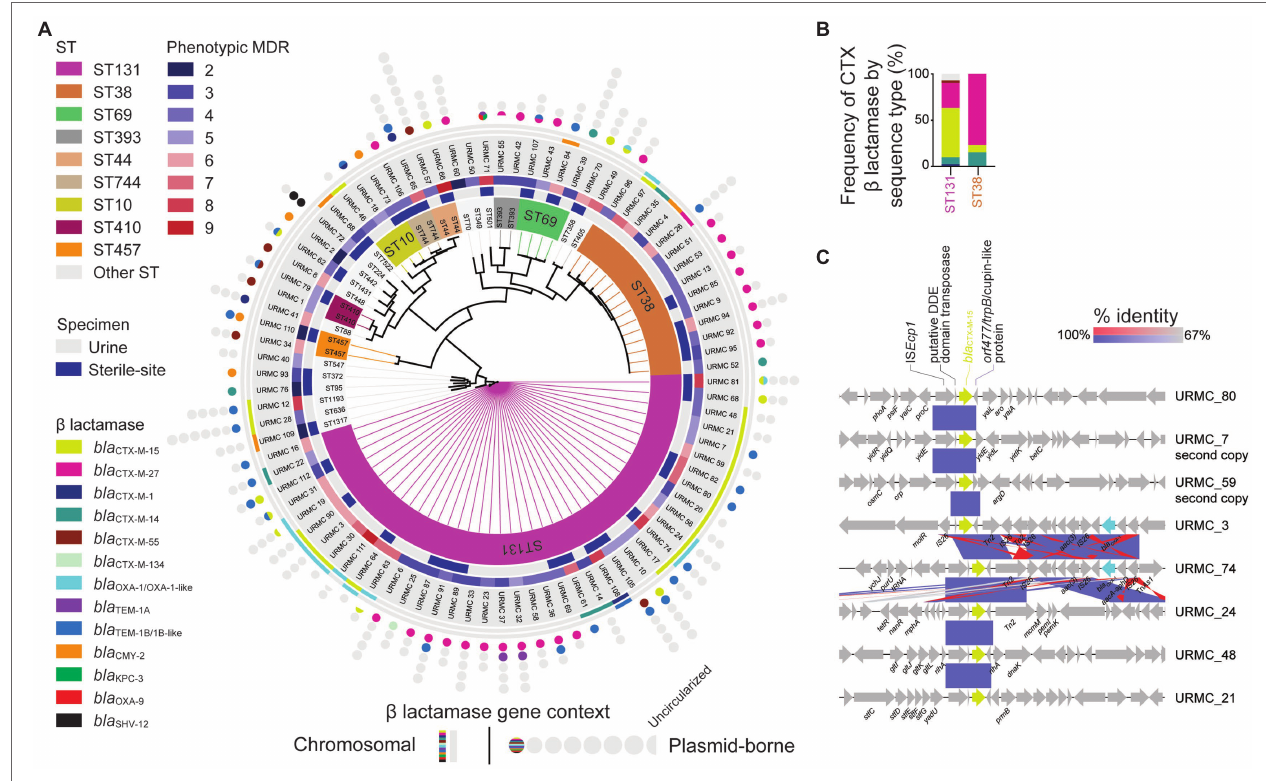
FIGURE 2 | WGS SNP-based phylogenomic tree and ST distribution of sequenced CTR E. coli . (A) Isolates (89 total) selected for WGS included those from urine (53 isolates) and sterile-sites (36 total: 28 blood, 4 bone, 2 peritoneal fluid, 1 joint fluid, and 1 drain) specimens. Detected ARGs are displayed as chromosomal (lines) or plasmid-borne (circles). Circles indicate the number of plasmids identified in each E. coli isolate. Half-circles indicate incomplete sequences. (B) Relative frequency of β -lactamase genes detected in E. coli ST131 and ST38 STs. (C) Gene context schematic of representative bla CTX-M-15 gene chromosomal insertion